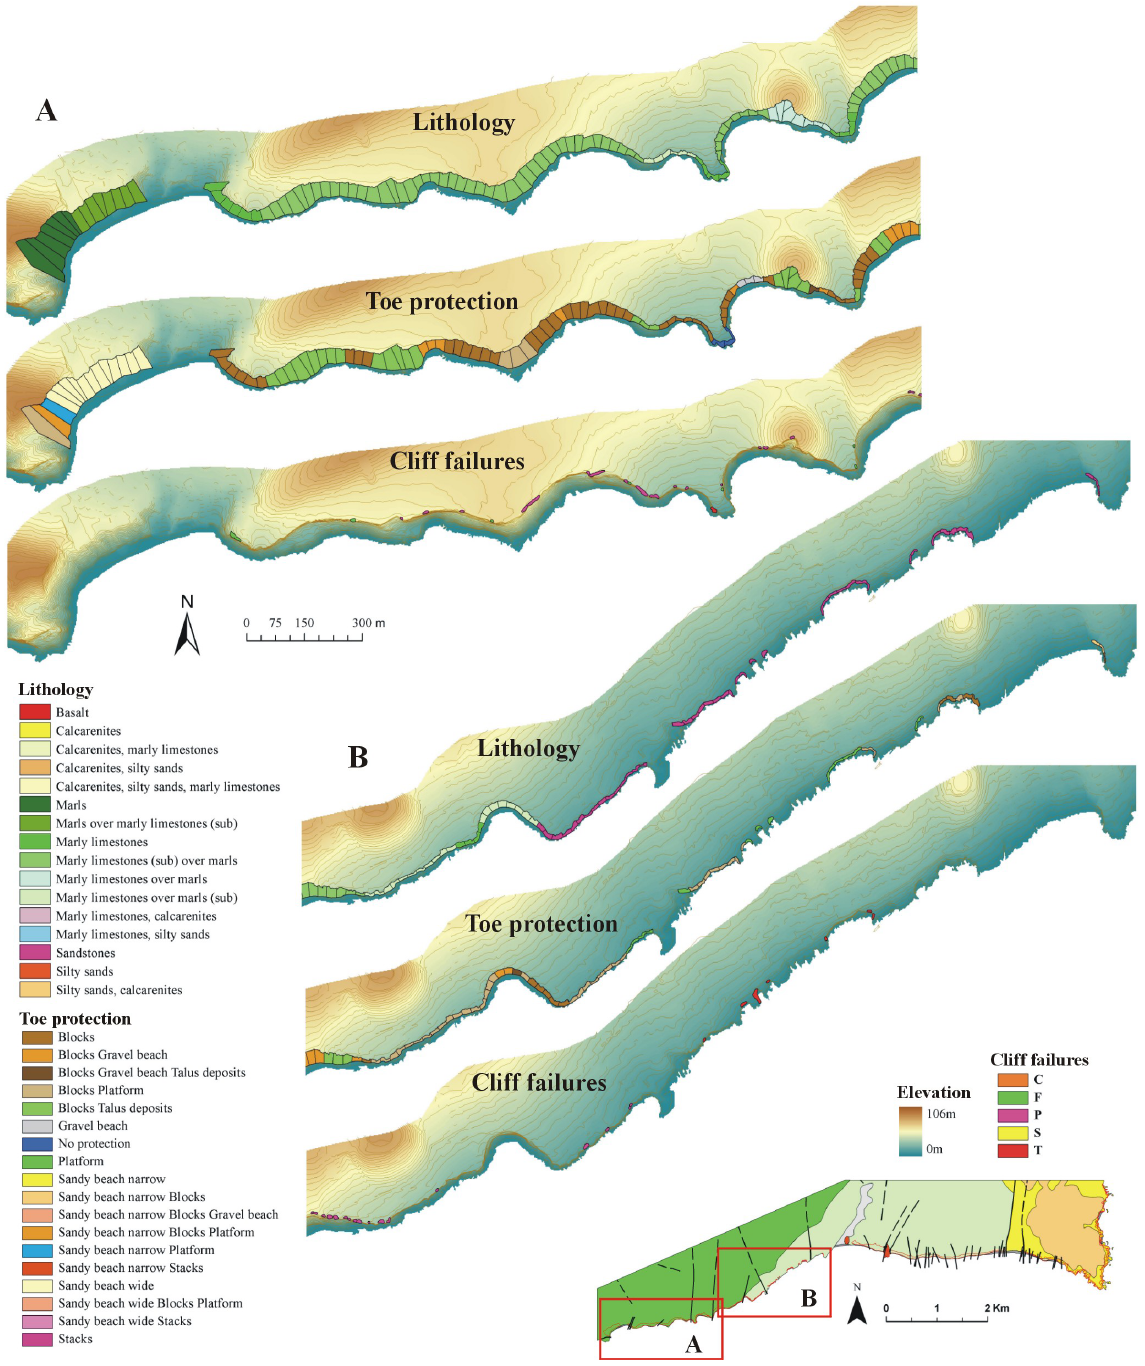
Fig. 6a. Lithology, toe protection and cliff failures in sections A and B. Lithology and toe protection mapped according to the terrain units used in this study. Cliff failure areas are not to scale to enable visualization. Cliff failures legend: C – Complex and not determined; F – Rockfalls; P – Planar failures; S – Slumps; T – Toppling failures. Contour line interval is 2m.